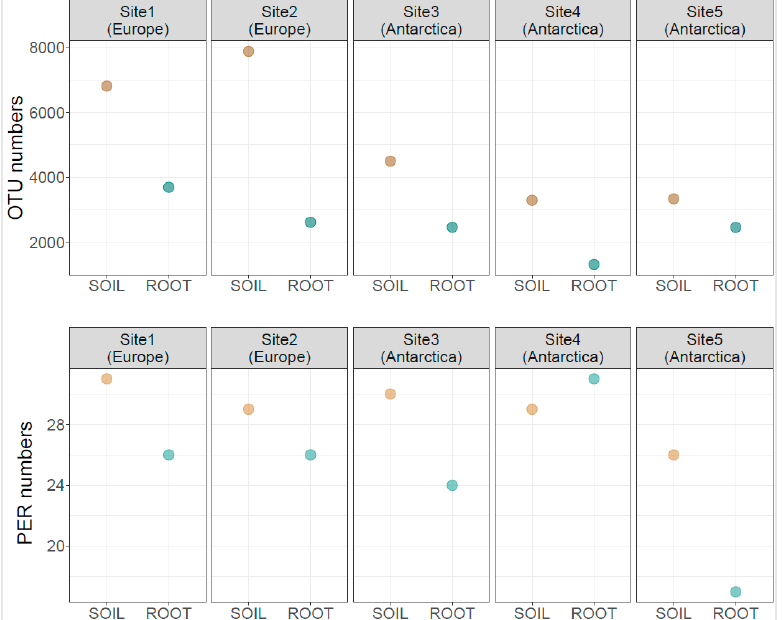
Figure 1. Operational taxonomic unit (OTU) numbers (upper graphs) and positive EcoPlate re- sponse (PER) numbers (lower graphs) for the bacterial communities associated with Poa annua roots. OTU numbers represent a value derived from three pooled samples; positive EcoPlate responses are the mean value of 9 replicates.